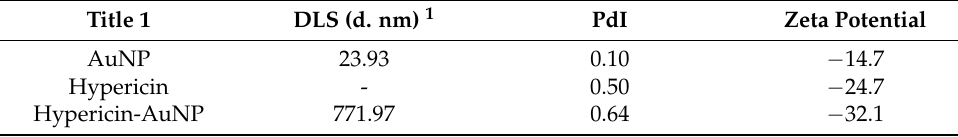
Table 1. DLS, PdI, and Zeta potential